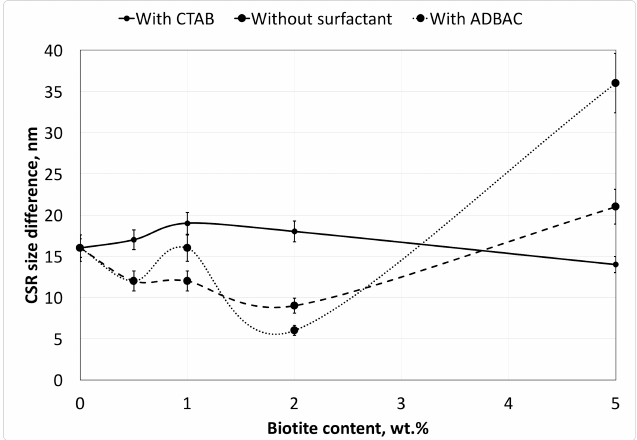
Figure 4. Changes in the coherent scattering region (CSR) size with different surfactant species as a function of biotite content in the polymer composites. CTAB: cetyltrimethylammonium bromide; ADBAC: alkyldimethylbenzylammonium chloride.